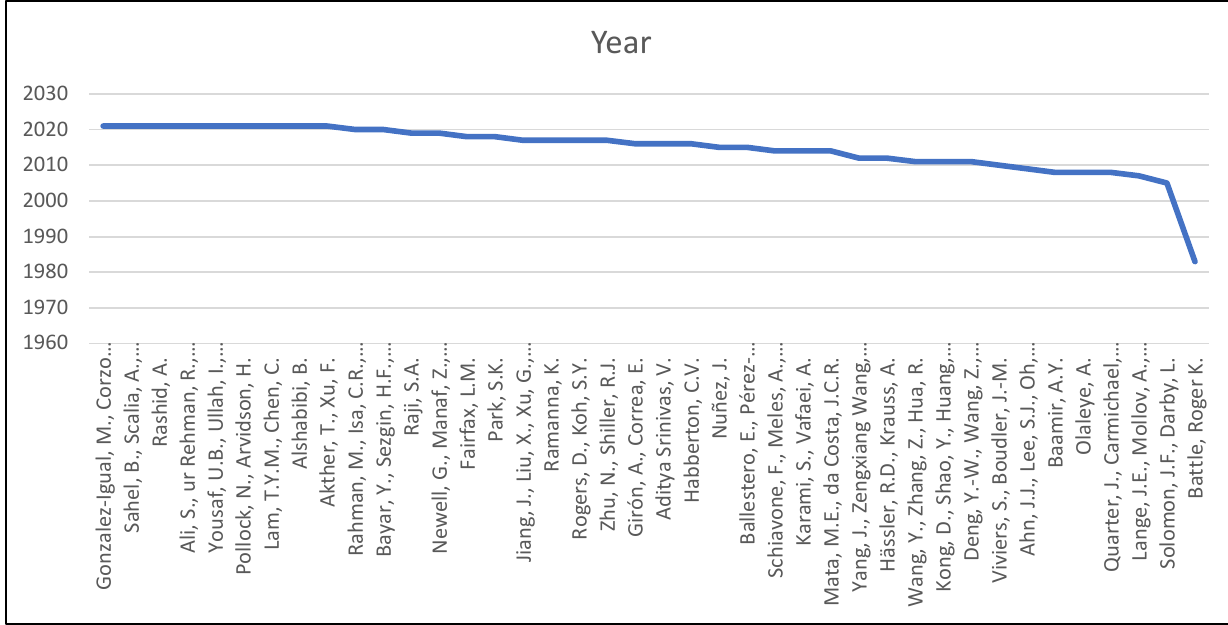
Figure 3. Top Leading Journals.